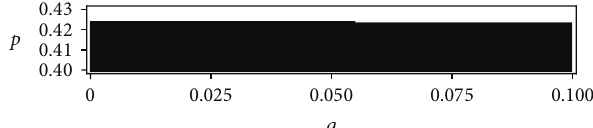
Figure 6: Existence of an order-1 periodic solution for system (1) versus the parameters 𝑝 and 𝑞 . In the black zone, there always exists an order-1 periodic solution in system (1). Note: this figure does not mean that there is no order-1 periodic solution in system (1).